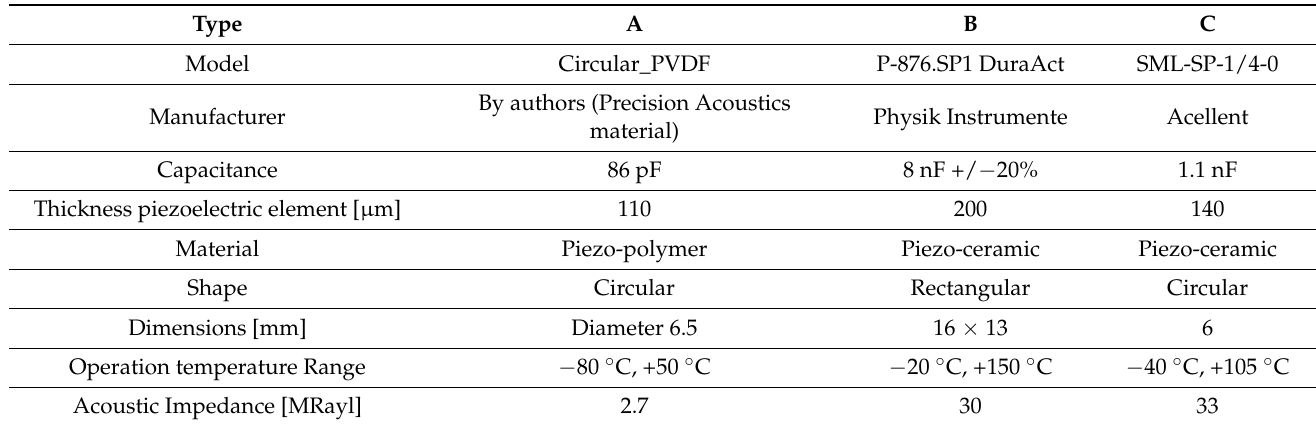
Table 1. Characteristics of Single Element Piezoelectric